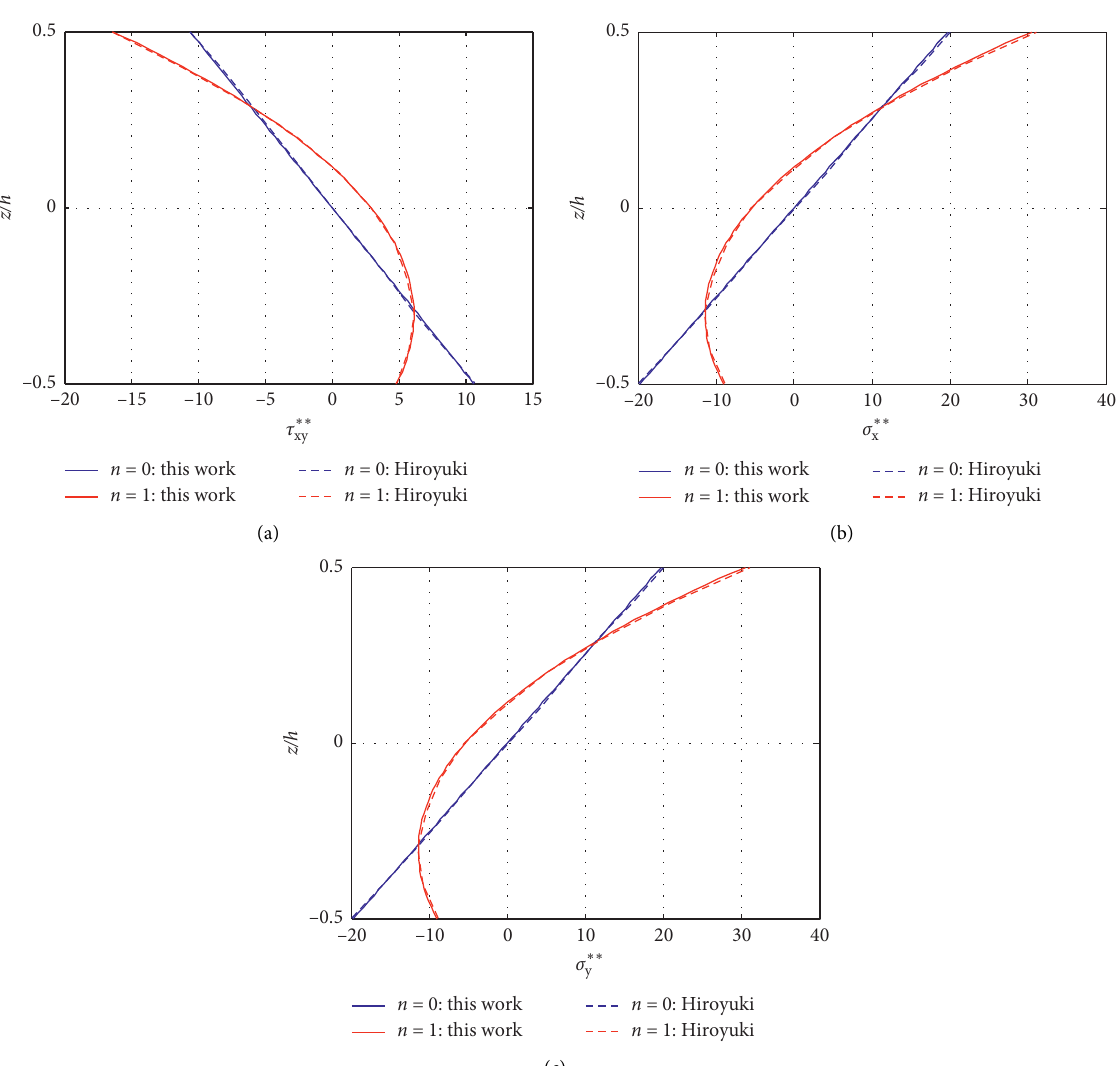
( 0 , 0 , z ) ; (b) σ ∗∗ (( a /2 ) , ( b /2 ) , z ) ; xy x